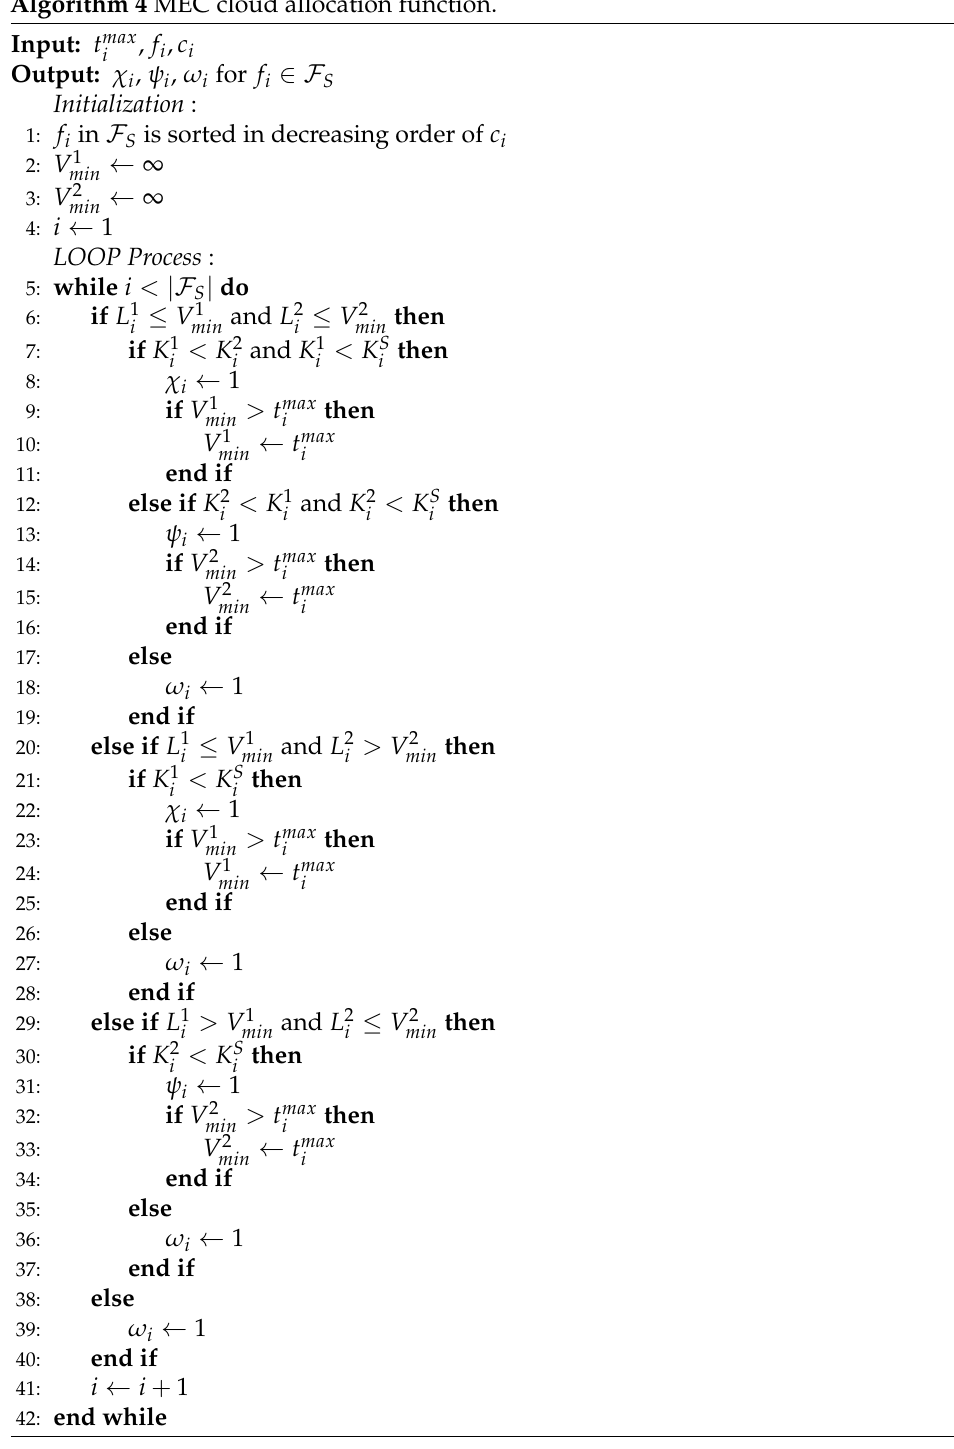
Algorithm 4 MEC cloud allocation